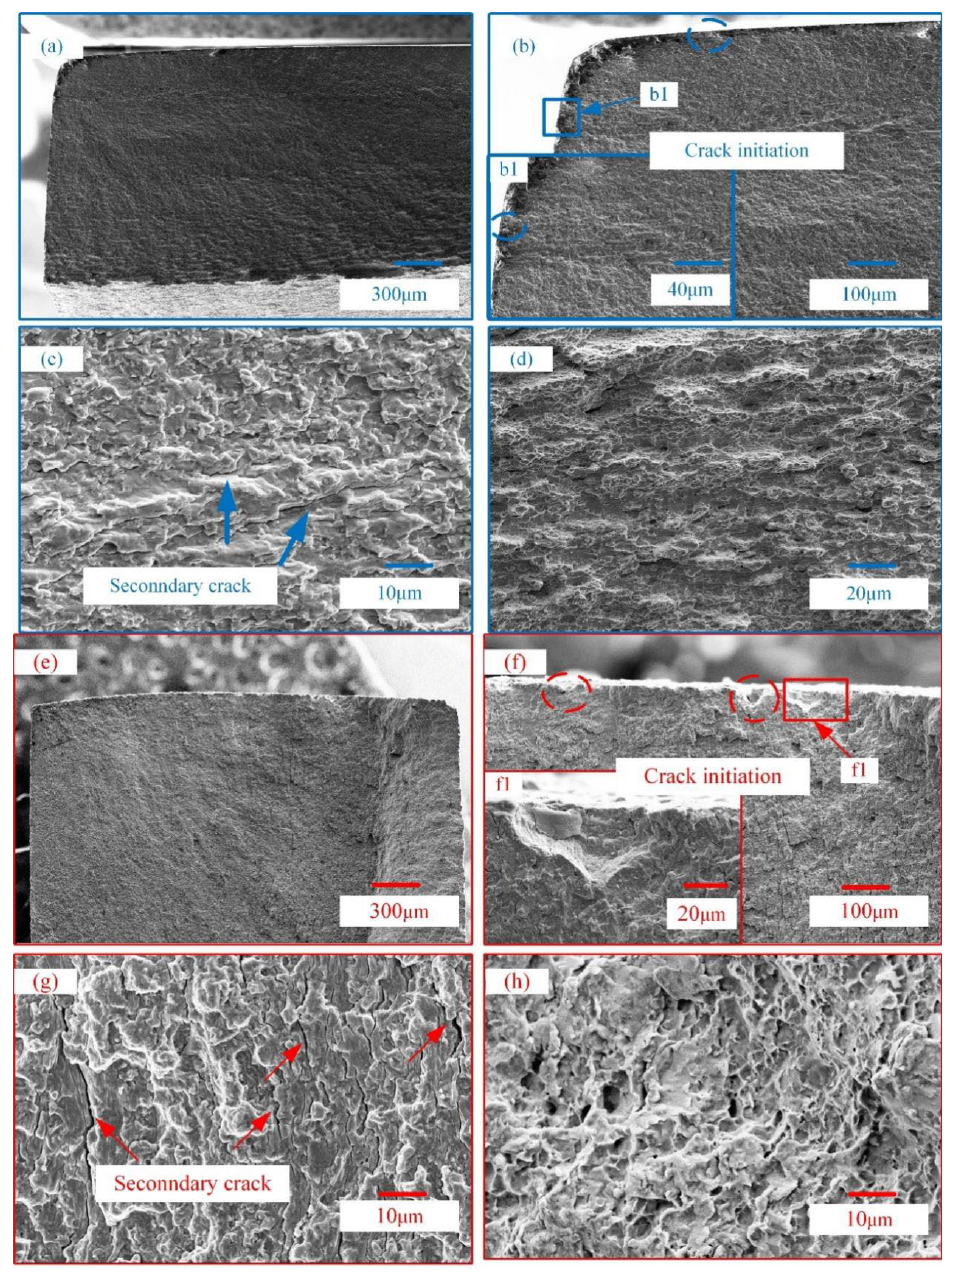
Figure 11. Fatigue morphologies of substrate sample A ( a , b , b1 , c , d ) and PEO-coated sample A ( e , f , f1 , g , h ) under 850 MPa.